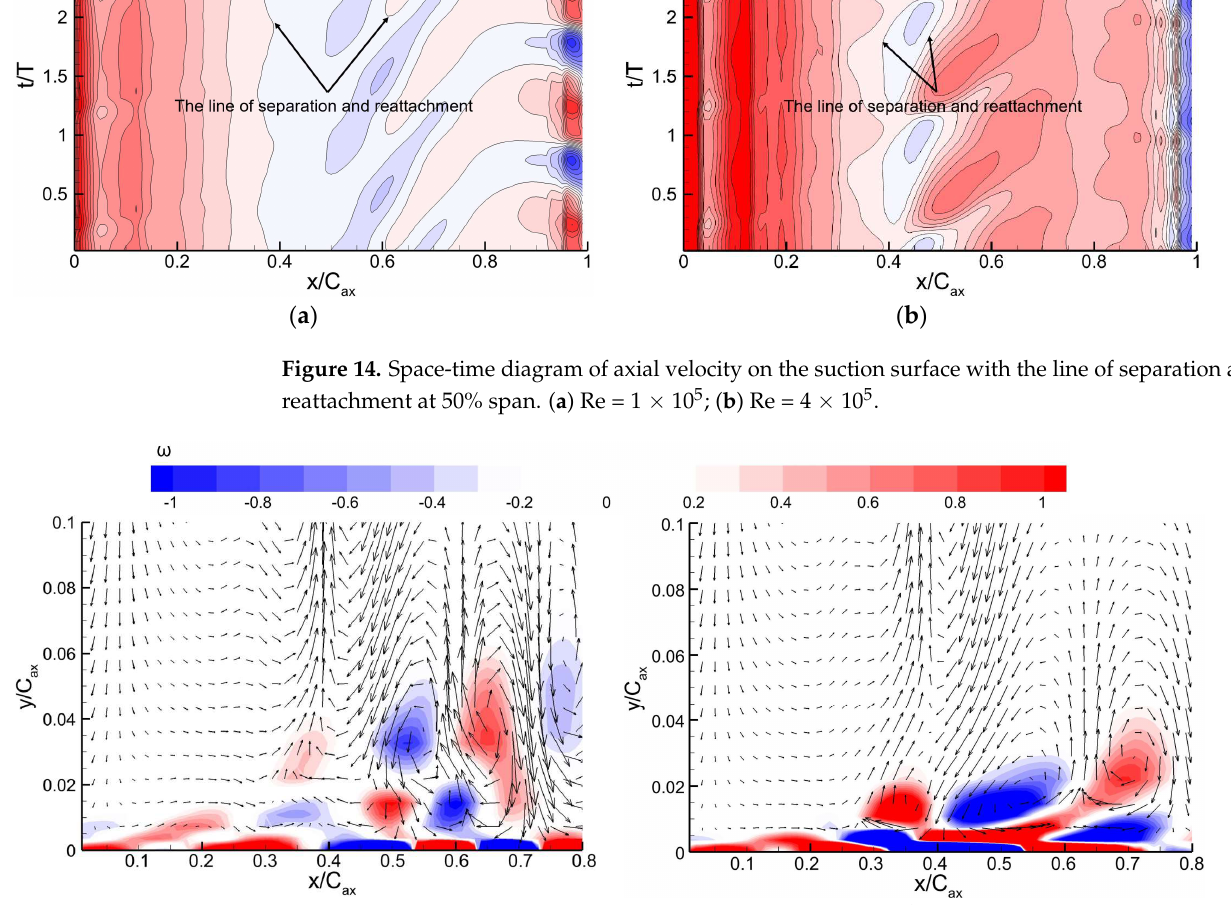
( b ) Figure 16. Distribution of the transient intermittency and K-H instability on the suction surface at 50% span. ( a ) Re = 1 × 10 5 ; ( b ) Re = 4 × 10 5. 3.3. Effect of Wake on the Tip Flow Field at Different Re According to the analysis in Section 3.1, the upstream wake and TCV have strong unsteady effects, which in turn influence the compressor performance. The unsteady in- teraction varies with Re. The contours of the static entropy with wake and its difference with no wake at 99% span are shown in Figure 17, illustrating the influence of the wake on the flow loss of the tip flow field. The calculation method of the difference in entropy is consistent with Figure 9. For the result with the wake at Re = 4 × 10 5 , the high-entropy region is concentrated in the region influenced by the TCV and develops from the suction side leading edge across the flow passage to the pressure surface of the adjacent blade. According to the difference in entropy at Re = 4 × 10 5 , there is a strip in which the entropy is increased by the interaction in front of the TCV. Although the direct mixing effect caused by the wake rapidly increases the entropy, the unsteadiness of the wake changes the TCV intensity by influencing the blade loading, resulting in a reduction in flow loss because of boundary layer separation at the trailing edge. As the entropy reduction out- weighs the entropy increase, the flow blockage becomes weaker at the tip region. In the case of a wake with Re = 1 × 10 5 , the high-entropy region has a greater range over the